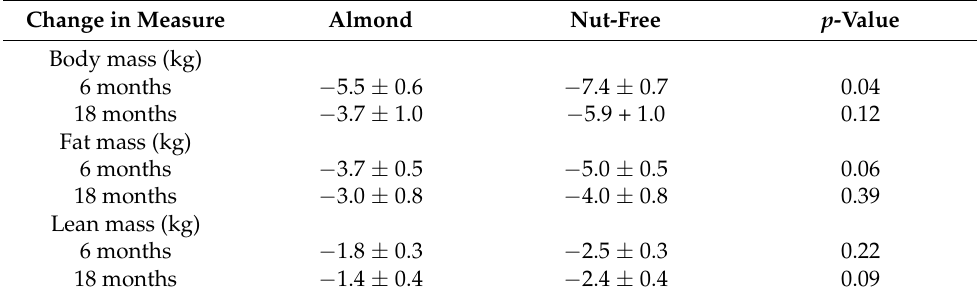
Table 4. Mean changes in weight measures for 500 kcal deficit almond-enriched and nut-free low- calorie diets (LCDs)